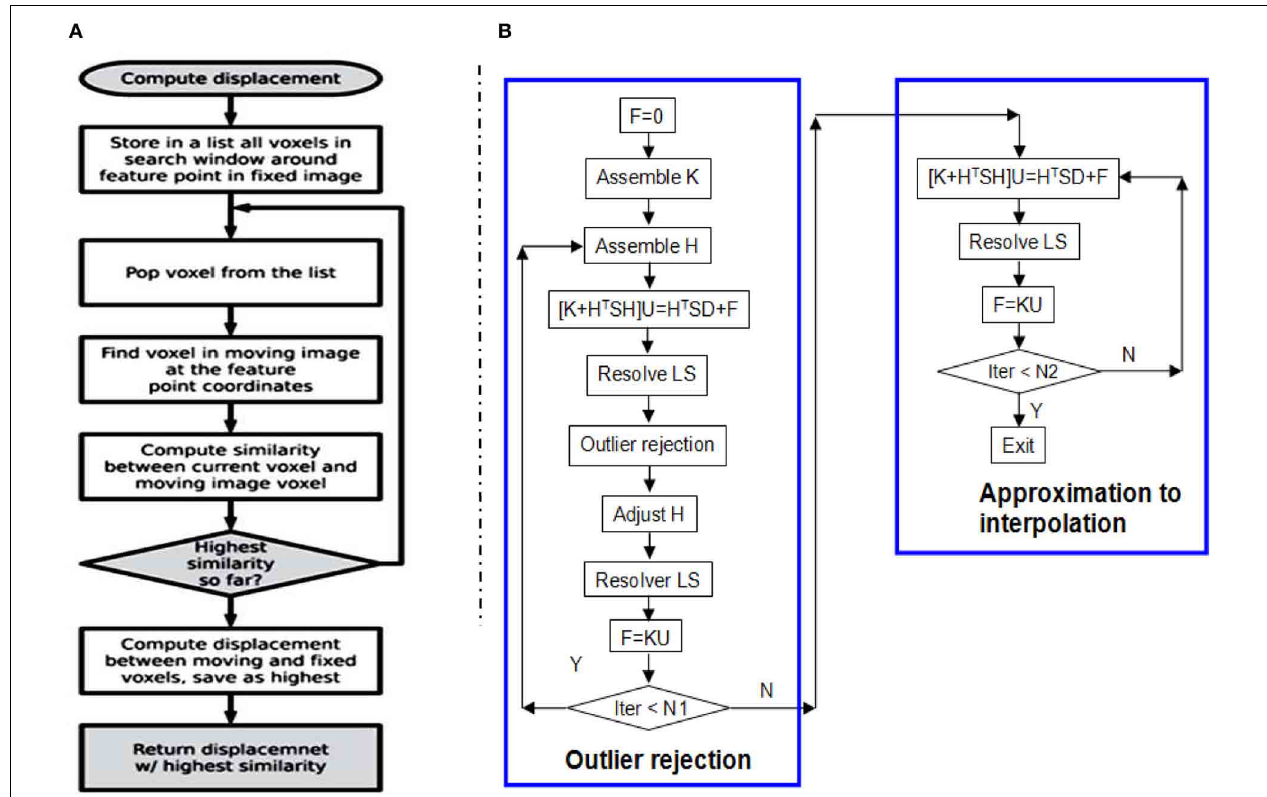
FIGURE 3 | (A) The flow chart of one thread/kernel of block matching. (B) The flow chart of RobustSolver. RobustSolver includes two parts: outlier rejection and approximation to interpolation. Outlier rejection proceeds as a LTS regression (Liu et al., 2009): resolve U first, then detect outliers, remove outliers, and resolve U again. The F is used to reset the strain energy to